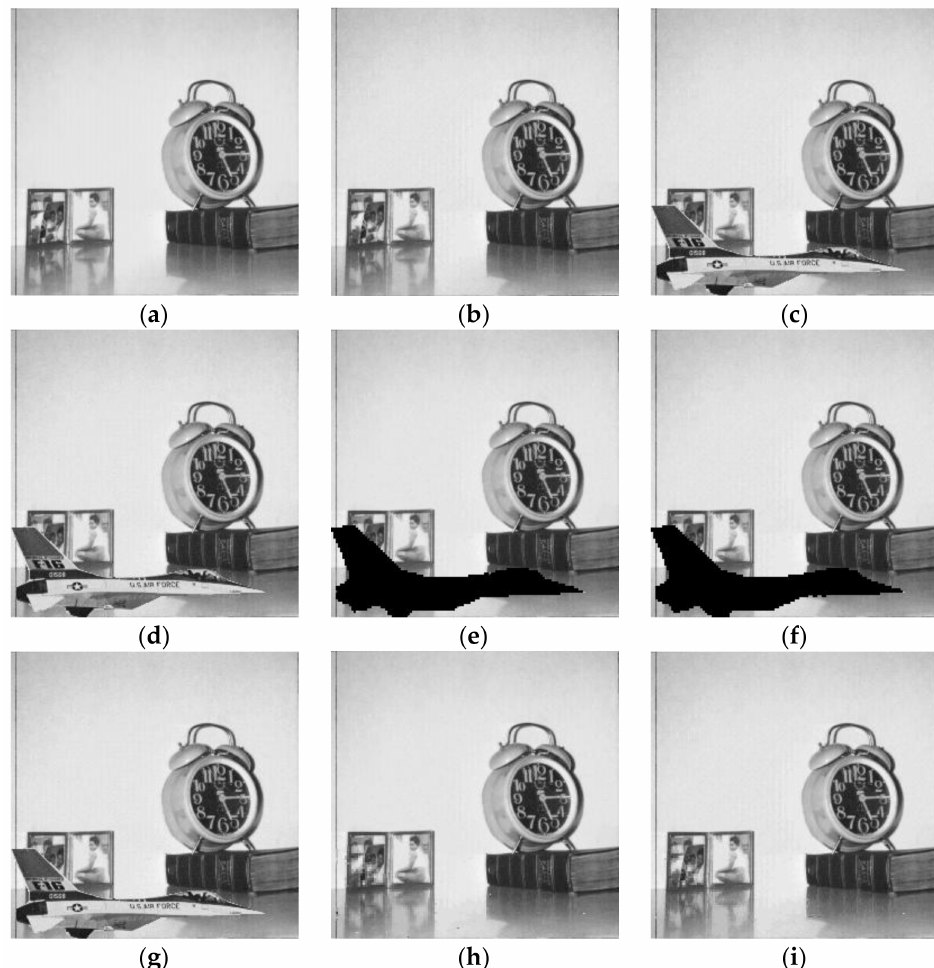
Figure 11. Tamper detection and recovery performance for content-only attack: ( a ) Original Clock image; ( b ) watermarked Clock image; ( c ) attacked Clock image; ( d ) tamper detection result using the method in [13]; ( e ) tamper detection result using the method in [25]; ( f ) tamper detection result of the proposed method; ( g ) image recovery result using the method in [13]; ( h ) image recovery result using the method in [25]; ( i ) image recovery result of the proposed method.